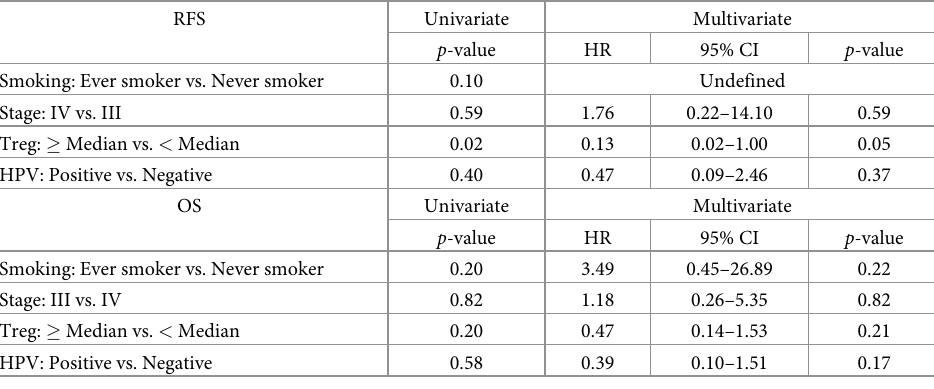
Table 2. Univariate and multivariate analyses of prognostic factors for